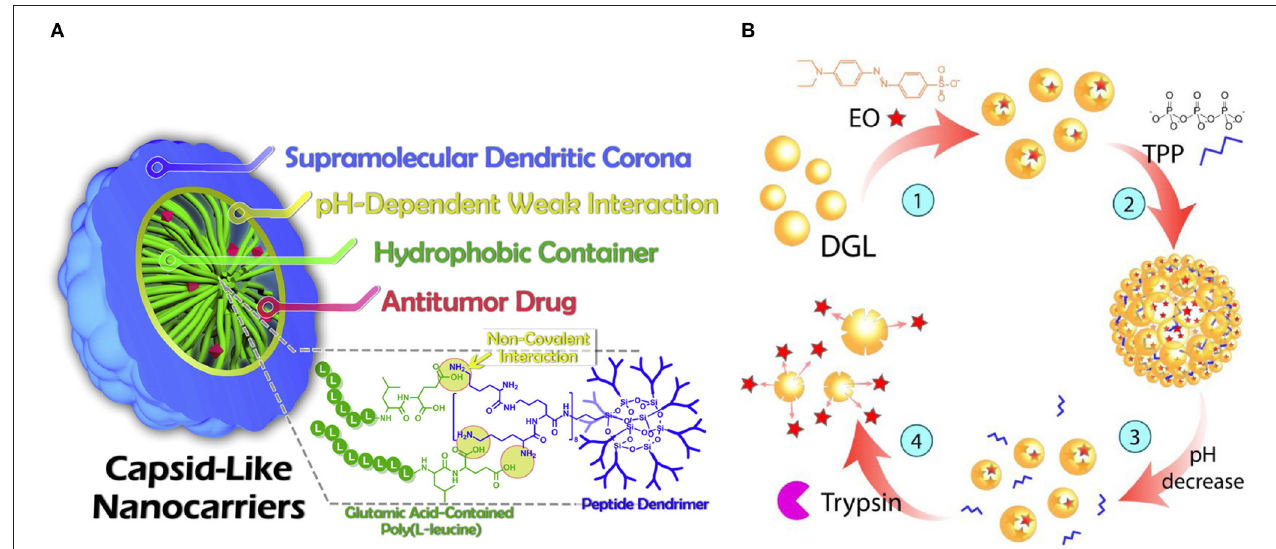
FIGURE 5 | Illustrations of two types of LBD conjugates for drug delivery system. (A) Non-covalent capsid-like nanocarriers (Li et al., 2016); (B) Drug delivery system with multistage stimuli responses ( Agazzi et al.,